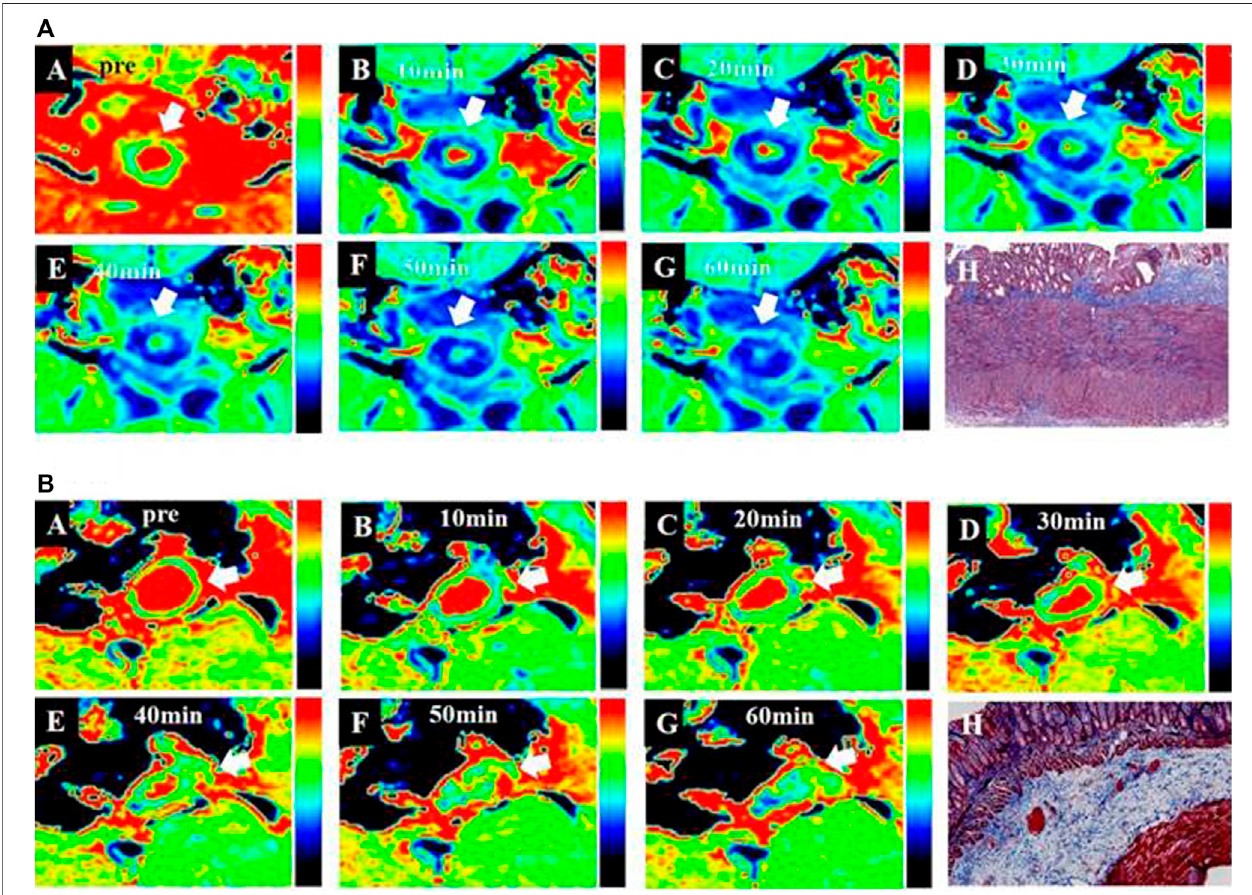
FIGURE 3 | T 1 maps of bowel wall fi brosis obtained from MR imaging according to the time stream after contrast media injection. (A) , T 1 maps from EP-3533 enhancedMRimaging:AtoGarethe T 1 mapsofamoderatebowelwall fi brosisbeforeandafterinjectingEP-3533.Bowelwall fi brosisisdepictedingreen (A) beforethe injection of EP-3533. After EP-3533 administration, bowel wall fi brosis marked by white arrows showed obvious enhancement in blue in the T 1 maps (B – G) . Masson ’ s trichrome staining (H) depicted moderate fi brosis (score (cid:2) 2). (B) , T 1 maps from Gd-DTPA enhanced MR imaging:A to G are the T 1 maps of moderate bowel wall fi brosis before and after injecting Gd-DTPA. Bowel wall fi brosis is also depicted in green (A) before injecting Gd-DTPA. After Gd-DTPA administration, the bowel wall fi brosis marked by white arrows showed mild enhancement in green in the T – G) . Masson ’ s trichrome staining (P) depicted moderate fi brosis (score (cid:2) 2). 1 maps (B